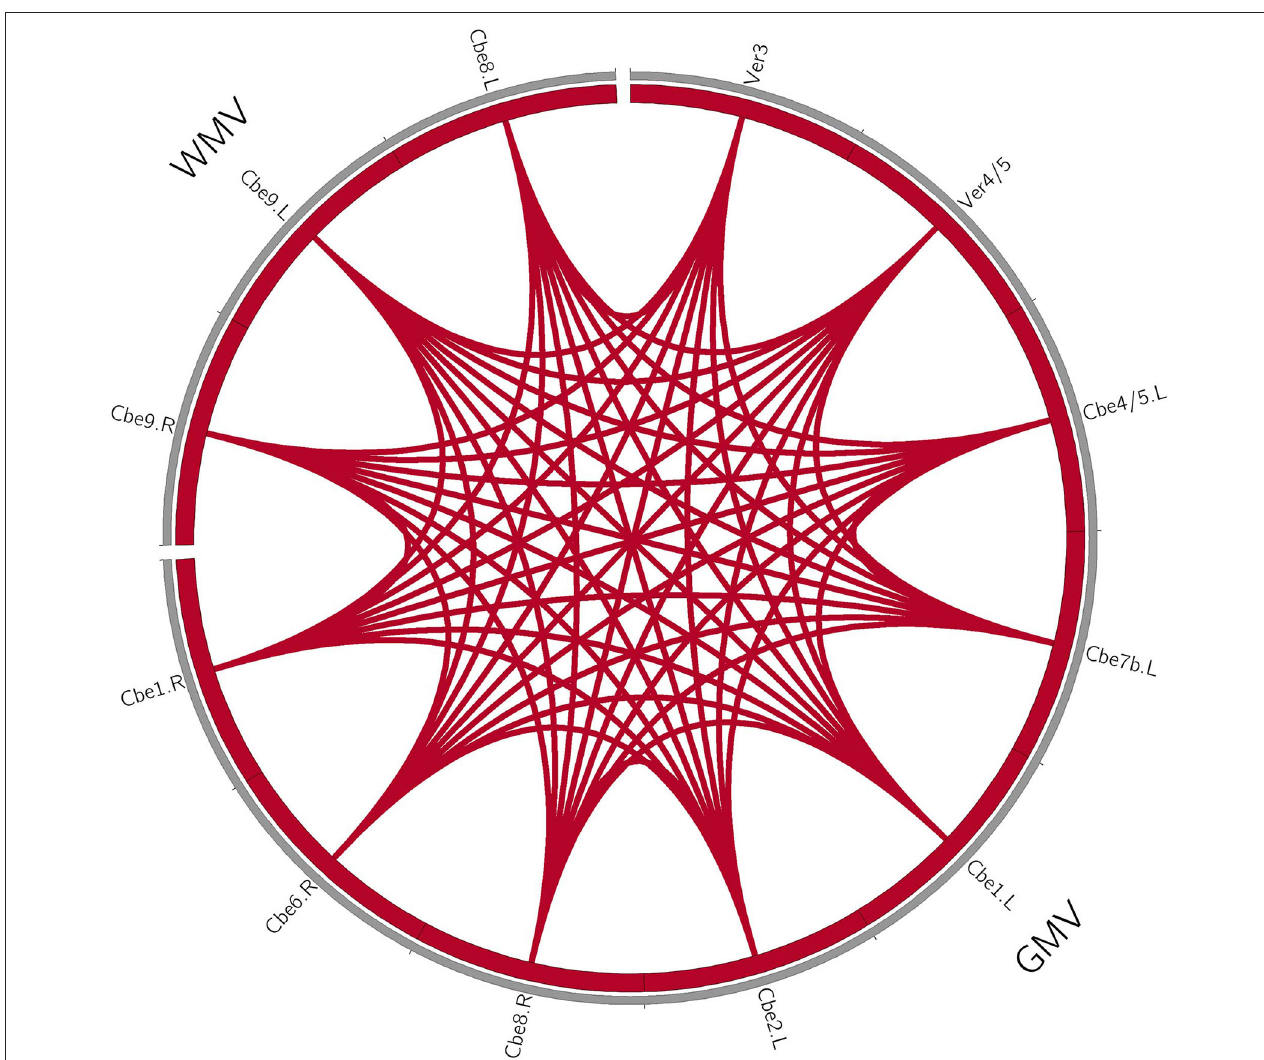
FIGURE 3 | Coupling relationships among perfusion, structure, and function in patients with MSA-p type. For patients with MSA-p type, we only found positive correlations within the structure changes. The red line denotes the increased correlations. GMV, gray matter volume; WMV, white matter volume; L, left; R, right; Cbe, cerebellum; Ver,